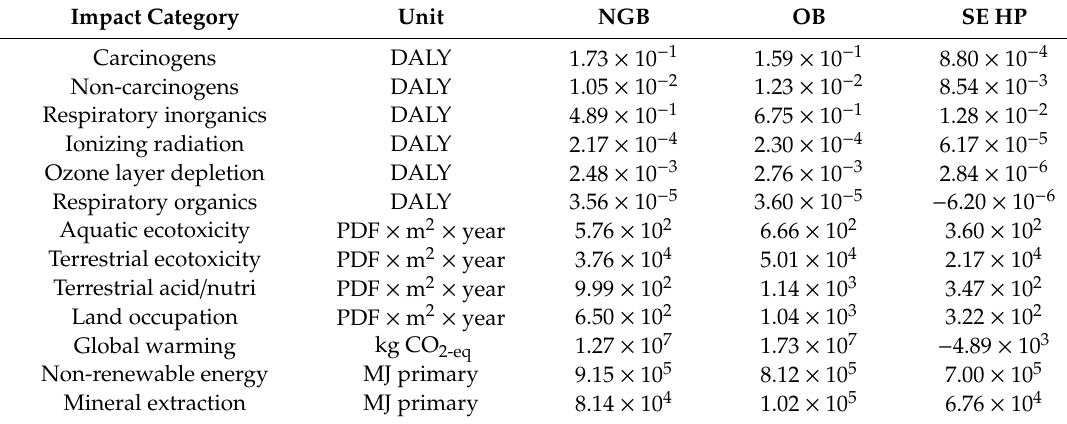
Table 6. Impact assessment and characterization for construction, 15 years of use, and end-of-life decommissioning of a Stirling cycle-based HP (SE HP), an oil boiler (OB), and a natural gas-fired boiler (NGB) for 500-kW heat output.